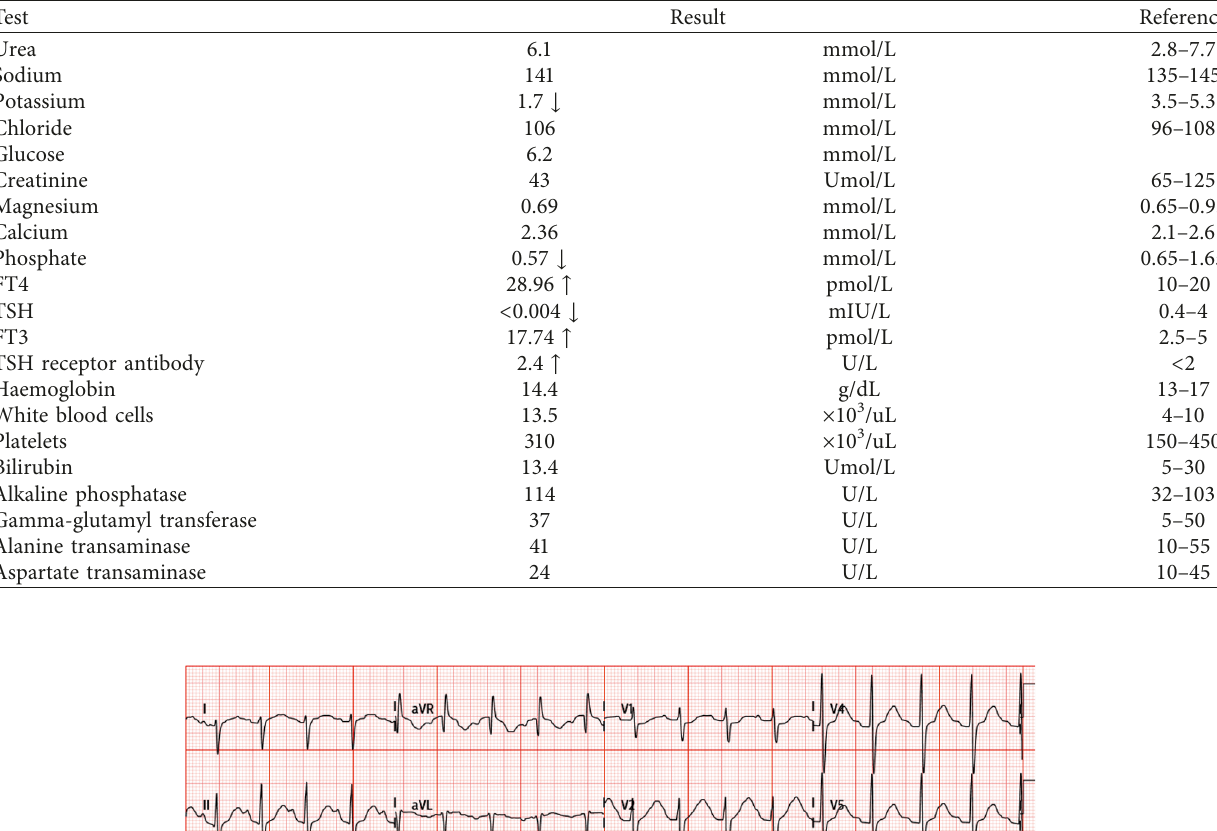
Table 1: Initial investigations